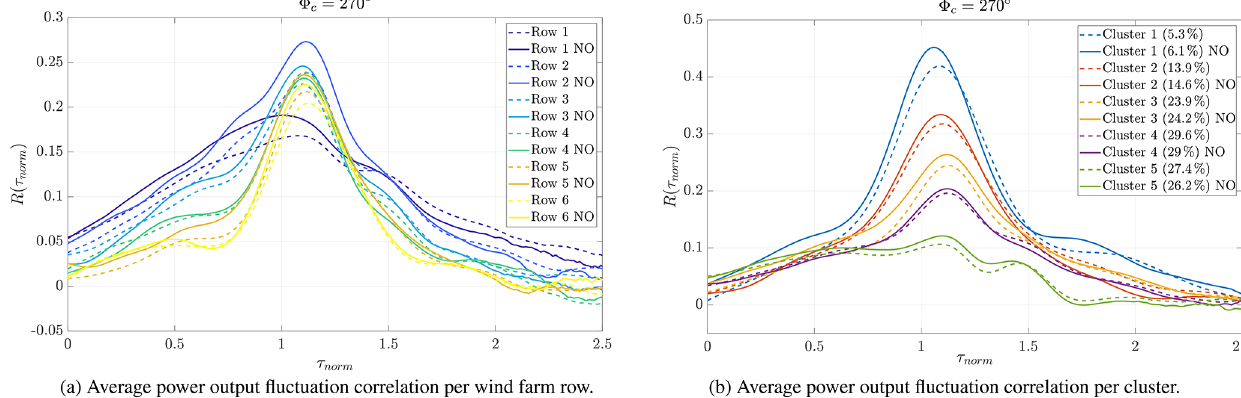
Figure B1. Comparison of the average power output fluctuation correlation for wind direction interval 270 ◦ of non-overlapping and overlap- ping intervals. For both plots, the average correlation curves for non-overlapping intervals are marked with “NO” and plotted with a dashed line. The average correlation curves for overlapping intervals are plotted in both cases as a solid